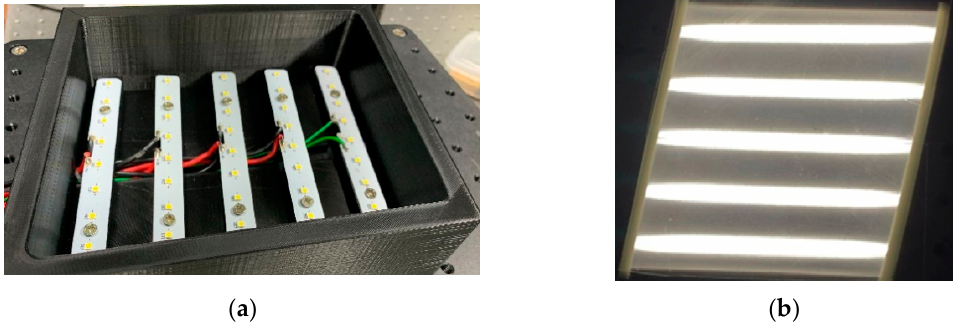
Figure 15. ( a ) The inner sight of the new optimized braking lamp; ( b ) the outlook of the new optimized braking lamp.